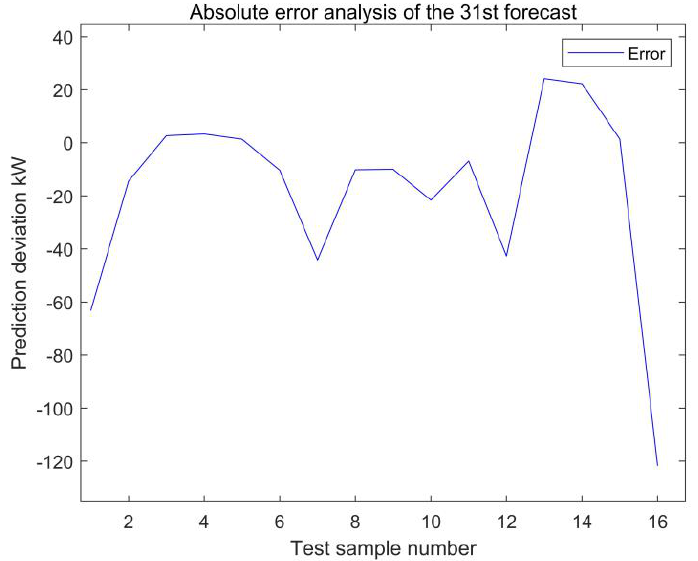
Figure 38. The absolute error plot of the prediction set.